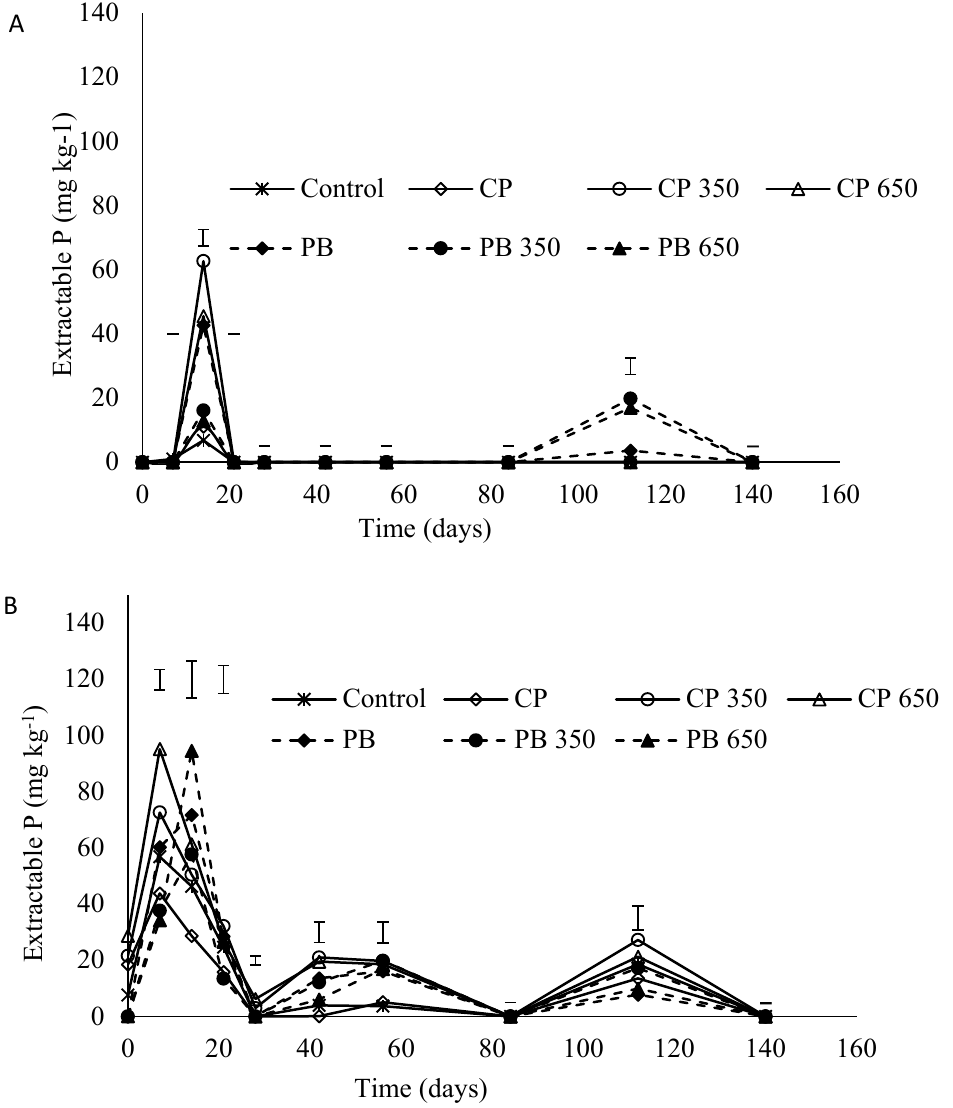
Figure 7. Concentrations of extractable P during incubation of Luvisol ( A ) and Ferralsol ( B ) amended with biochar from cull potato (CP) and pine bark (PB) produced at varying pyrolysis temperatures. CP = cull potato; PB = pine bark; CP 350 = cull potato biochar at 350 °C; CP 650 = cull potato biochar at 650 °C; PB 350 = pine bark biochar at 350 °C; PB 650 = pine bark biochar at 650 °C. The vertical error indicates LSD ( p < 0.05).